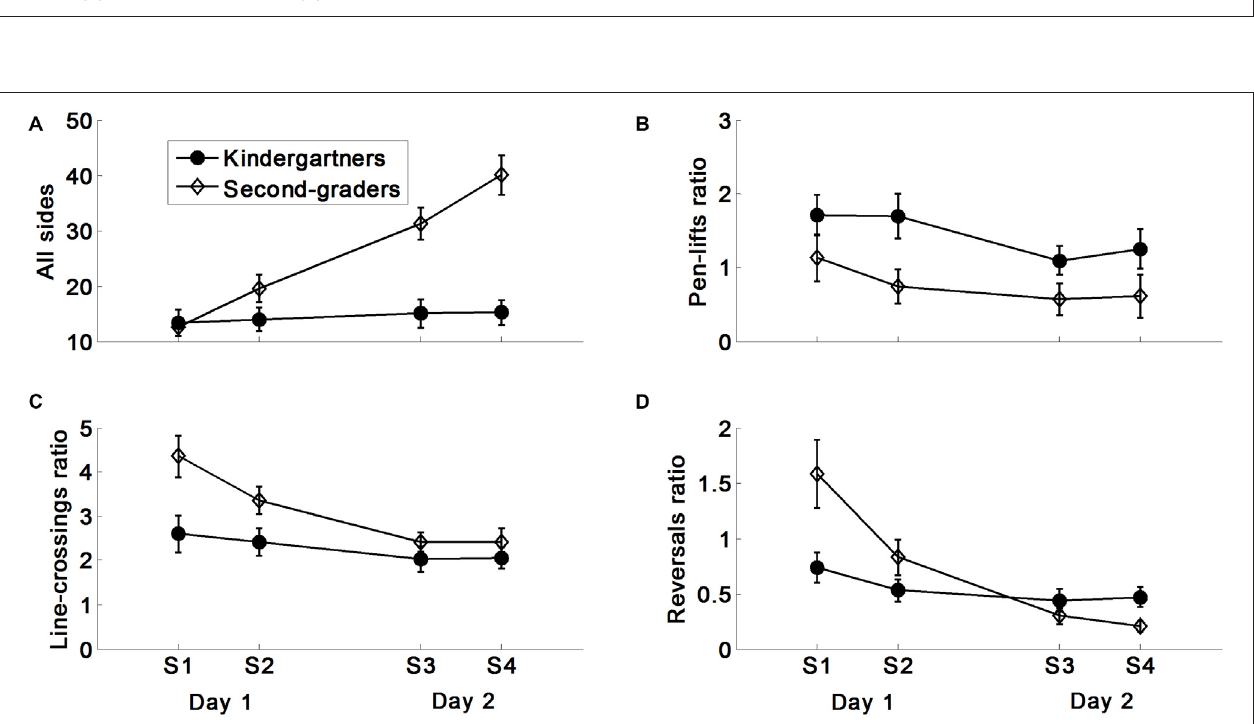
FIGURE 3 | Children’s production characteristics. (A) Overall number of sides. (B) Pen-lifts ratio. (C) Line-crossings ratio. (D) Reversals ratio. The ratios were computed as number per side.